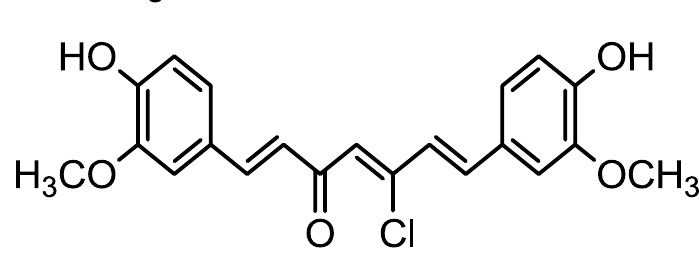
Figure 1. Structure of